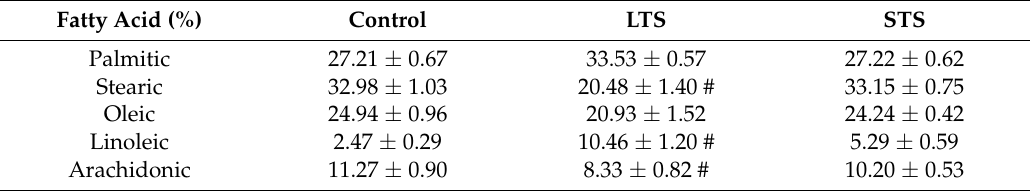
Figure 4. Effects of long-term (LTS) and short-term (STS) administration of sucrose on saturated fatty acids, monounsaturated fatty acids (MUFAs) and polyunsaturated fatty acids (PUFAs). Data represent mean ± SEM, # p < 0.05, n = 8 determinations from different rats in each group. Table 3. The effects of long-term (LTS) and short-term (STS) administration of sucrose on seric fatty acid composition. Data represent mean ± SEM, # p < 0.01, n = 8 determinations from 8 different rats from each group.